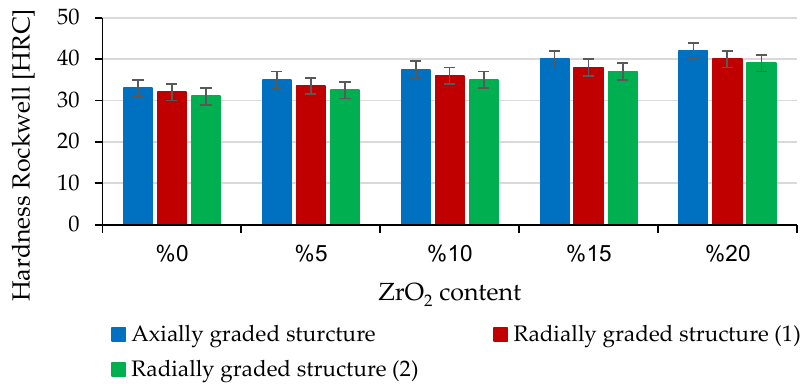
Figure 14. Changes in hardness with ZrO 2 distribution.